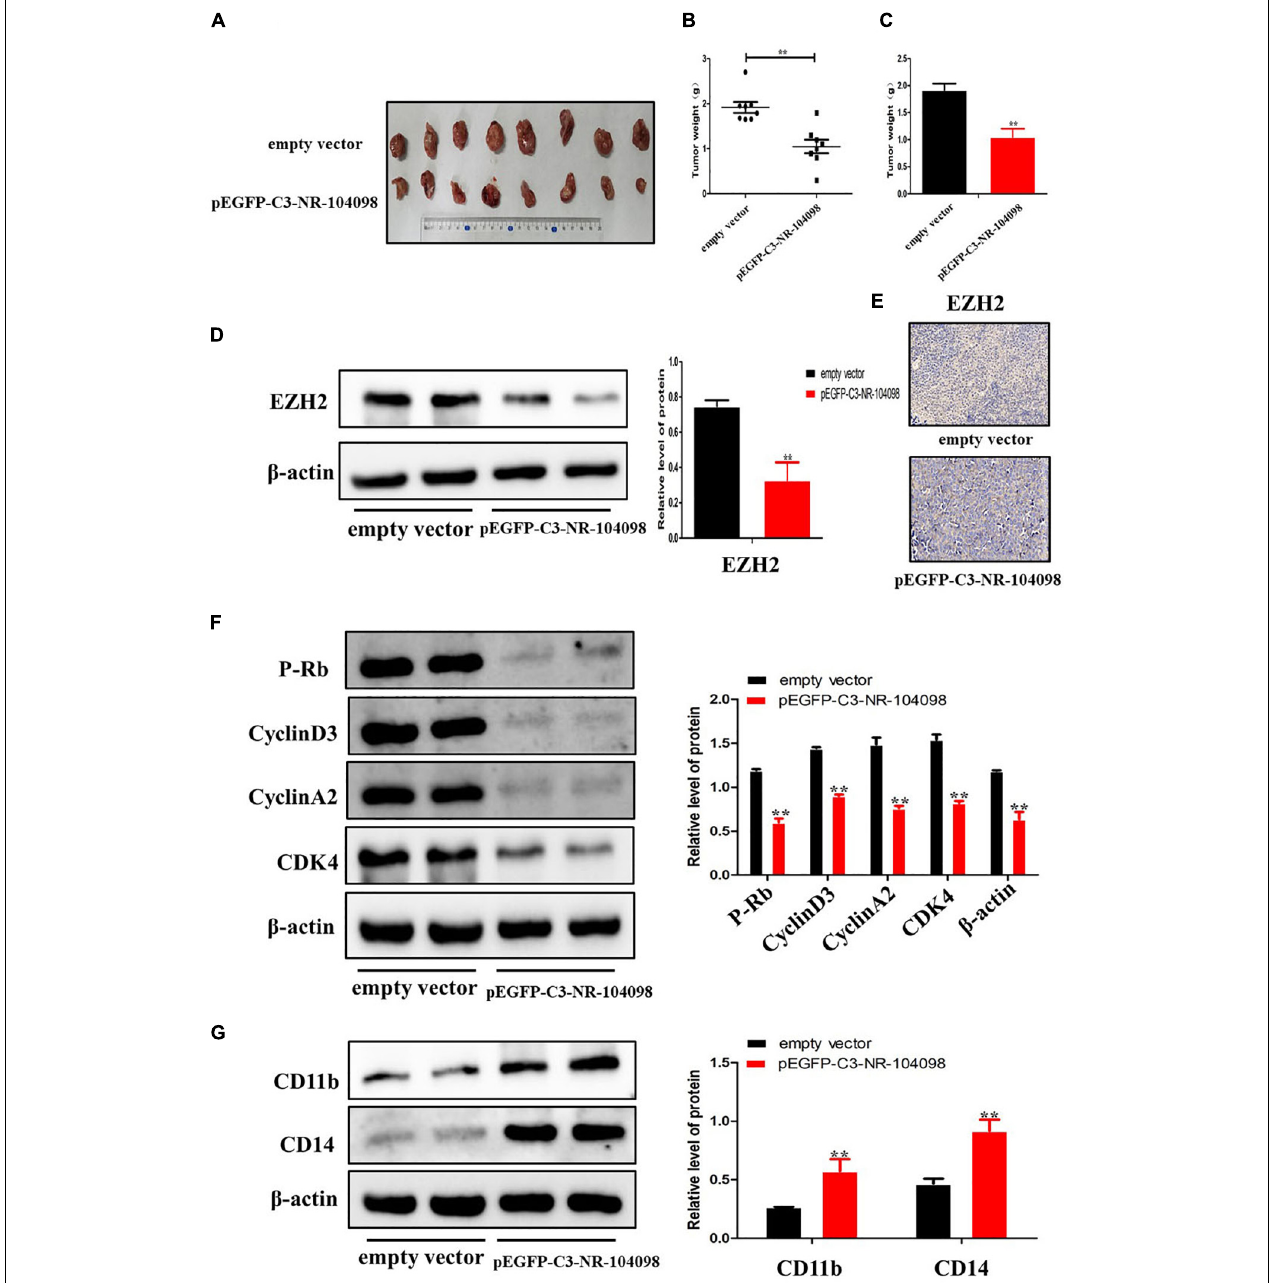
FIGURE 9 | Upregulation of lncRNA NR-104098 suppressed proliferation and induced differentiation of AML cells in vivo . Four-week-old NCG mice were randomly divided into two groups, and NB4 cells (1 × 10 6 ) with pEGFP-C3-NR-104098 or empty vector stable transfection were injected s.c. respectively. 8 weeks after that, the mice were sacrificed and the tumors were removed, photographed (A) , and weighed (B,C) . (D) Then, protein was extracted from the tumor tissues, and expressions of EZH2 protein was detected by Western blot. (E) Immunohistochemistry analysis of EZH2 was obtained from tumors. (F) Western blot analysis of cyclin D3, cyclin A2, P-rb, and CDK4 in tumor tissues of pEGFP-C3-NR-104098 or empty vector groups. (G) Western blot analysis of CD11b and CD14 in tumor tissues of pEGFP-C3-NR-104098 or empty vector groups. β -Actin served as a loading control. Data are presented as the mean ± SD of three independent experiments. ∗ p < 0.05, ∗∗ p < 0.01, significant difference between pEGFP-C3-NR-104098 and the empty